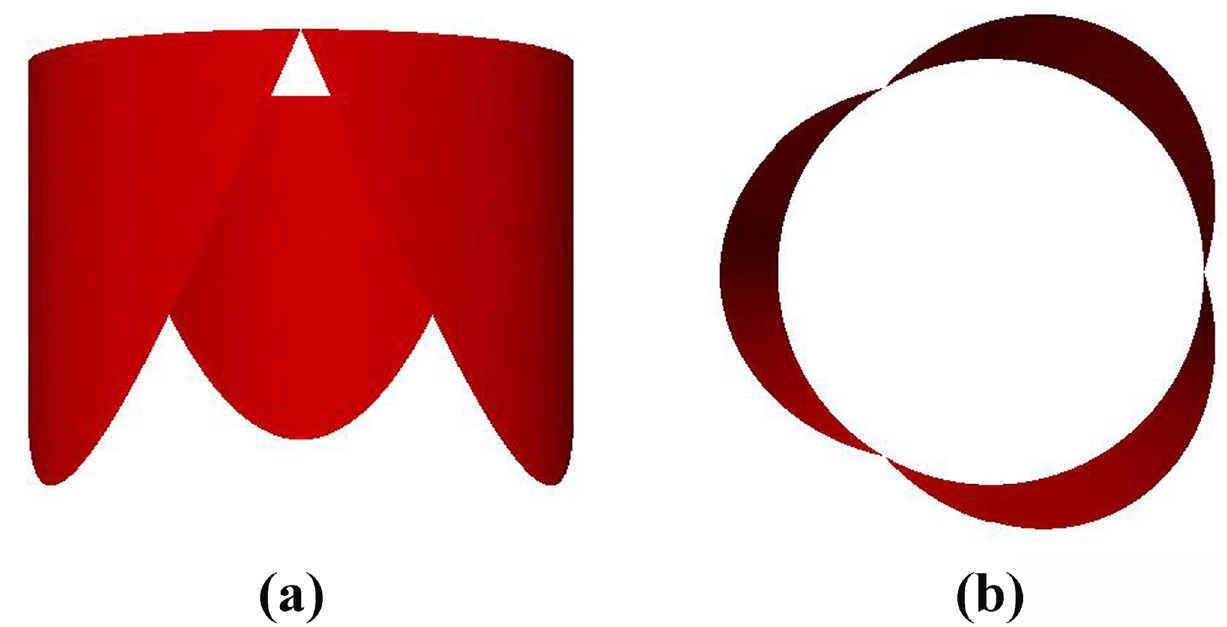
Fig 7. The combined graph of the human pulmonary valve cusps in three-dimensional space. (a) is the image observed from the front and (b) is the image observed from the